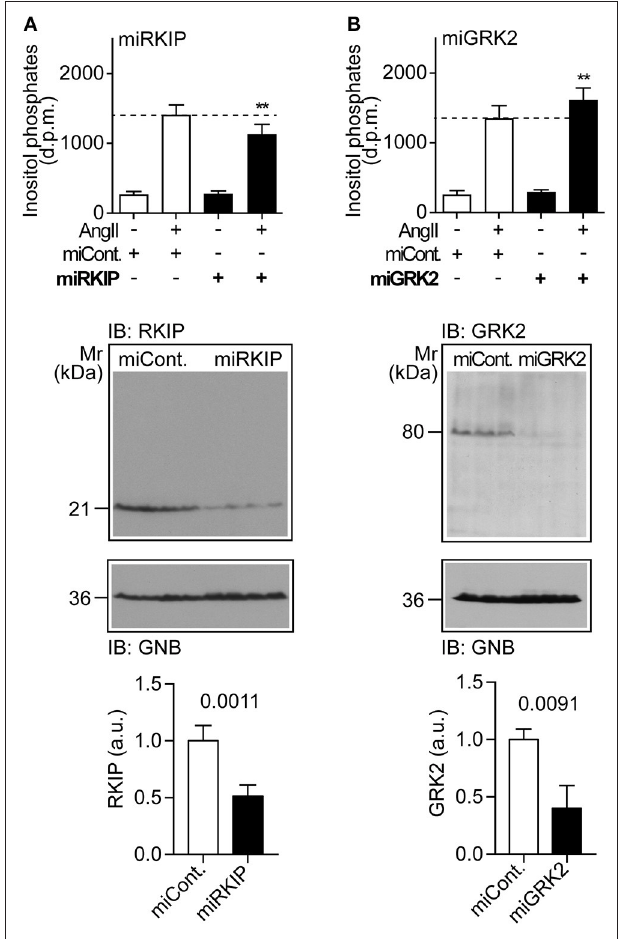
FIGURE 2 | Physiological RKIP levels are sufficient to sensitize AT1-stimulated signaling in cells. (A,B) Total inositol phosphate levels of AT1 receptor-expressing HEK cells stimulated without (–) or with ( + ) angiotensin II (100nM) and transfected without (–) or with ( + ) a control pre-miRNA (miCont) or a pre-miRNA targeting endogenously expressed RKIP (miRKIP) or GRK2 (miGRK2) by RNAi as indicated. Data represent mean ± s.d. ( n = 8; ** p < 0.01 vs. column 2; Dunnett’s test). The lower panels confirm RNAi-mediated down-regulation of endogenously expressed proteins by